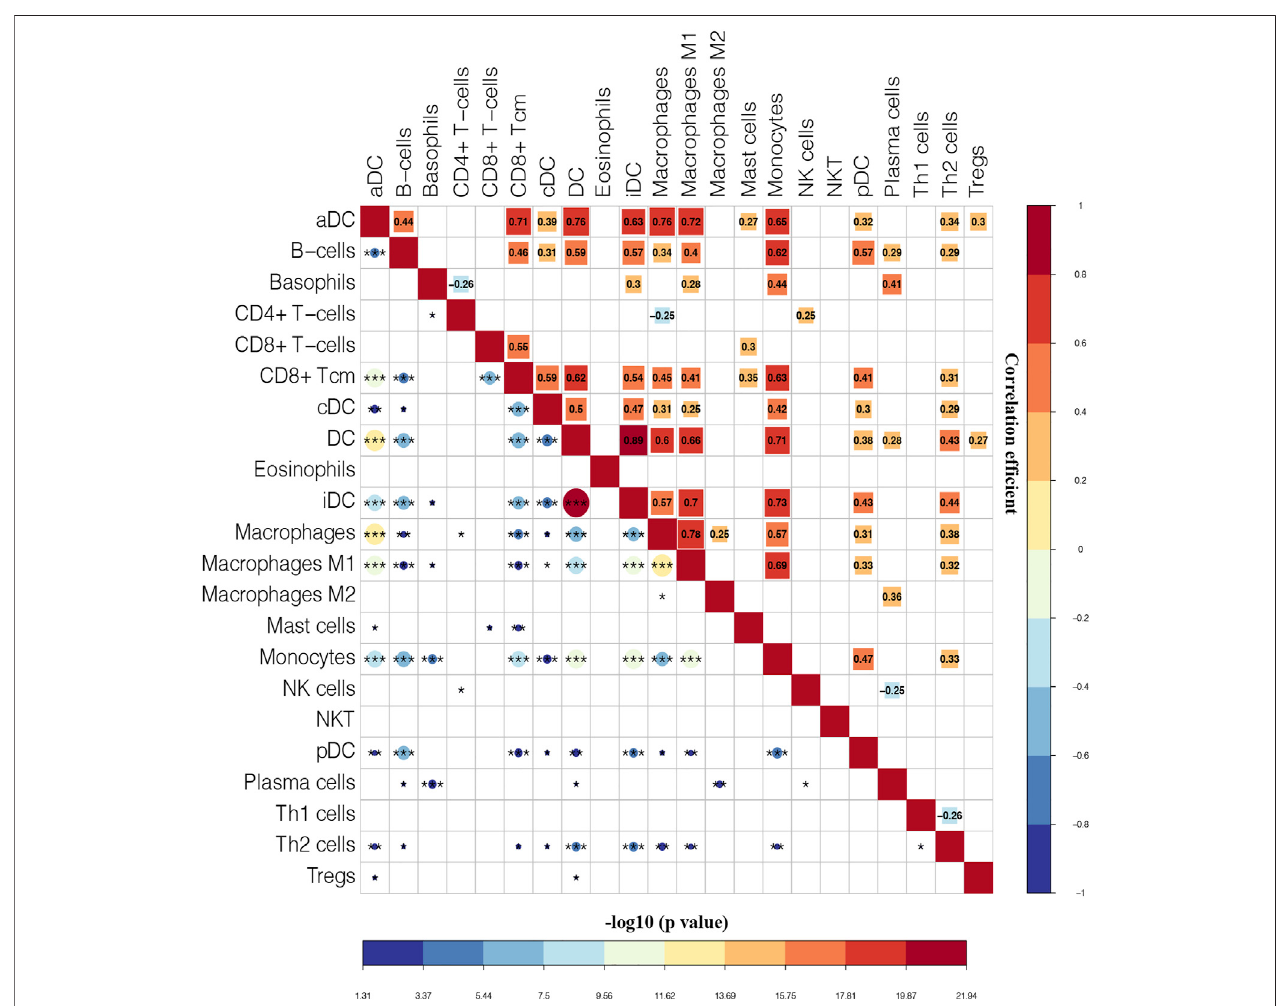
FIGURE5| Correlationmatrixofimmunecells.Bluesquaresrepresentnegativecorrelation,andredsquaresrepresentpositivecorrelation.Thesizeofthesquarein the upper right is positively correlated with the correlation coef fi cient. The size of the circle in the lower left is positively correlated with the signi fi cance of the correlation. * p < 0.05, ** p < 0.01, *** p <